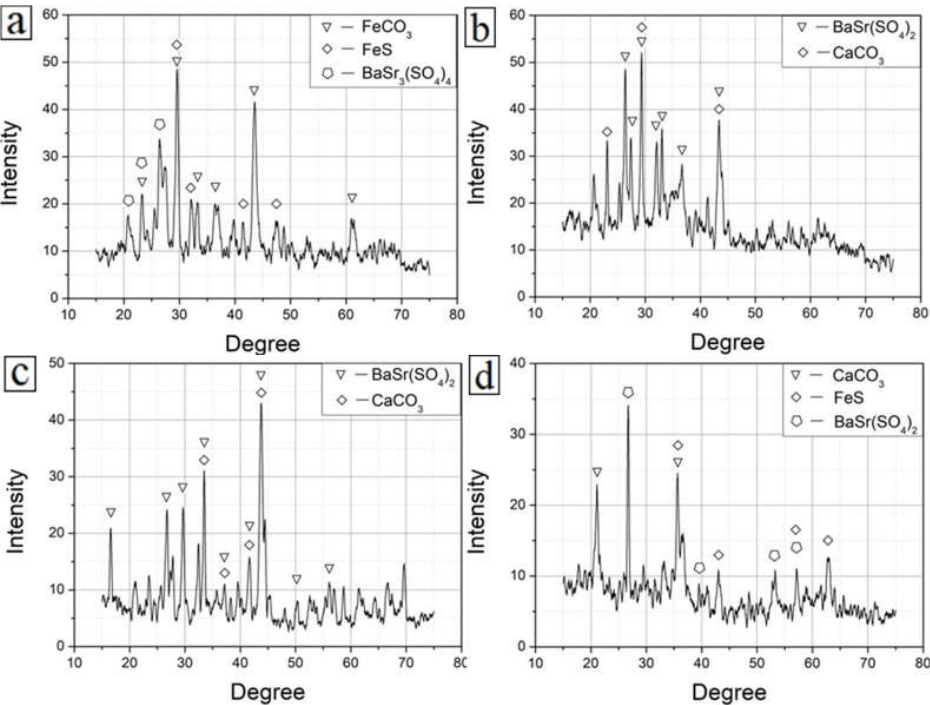
Figure 4. The XRD analysis results for hanging rings at: ( a ) Position #3, ( b ) Position #6, ( c ) Position #8, and ( d ) Position #9.